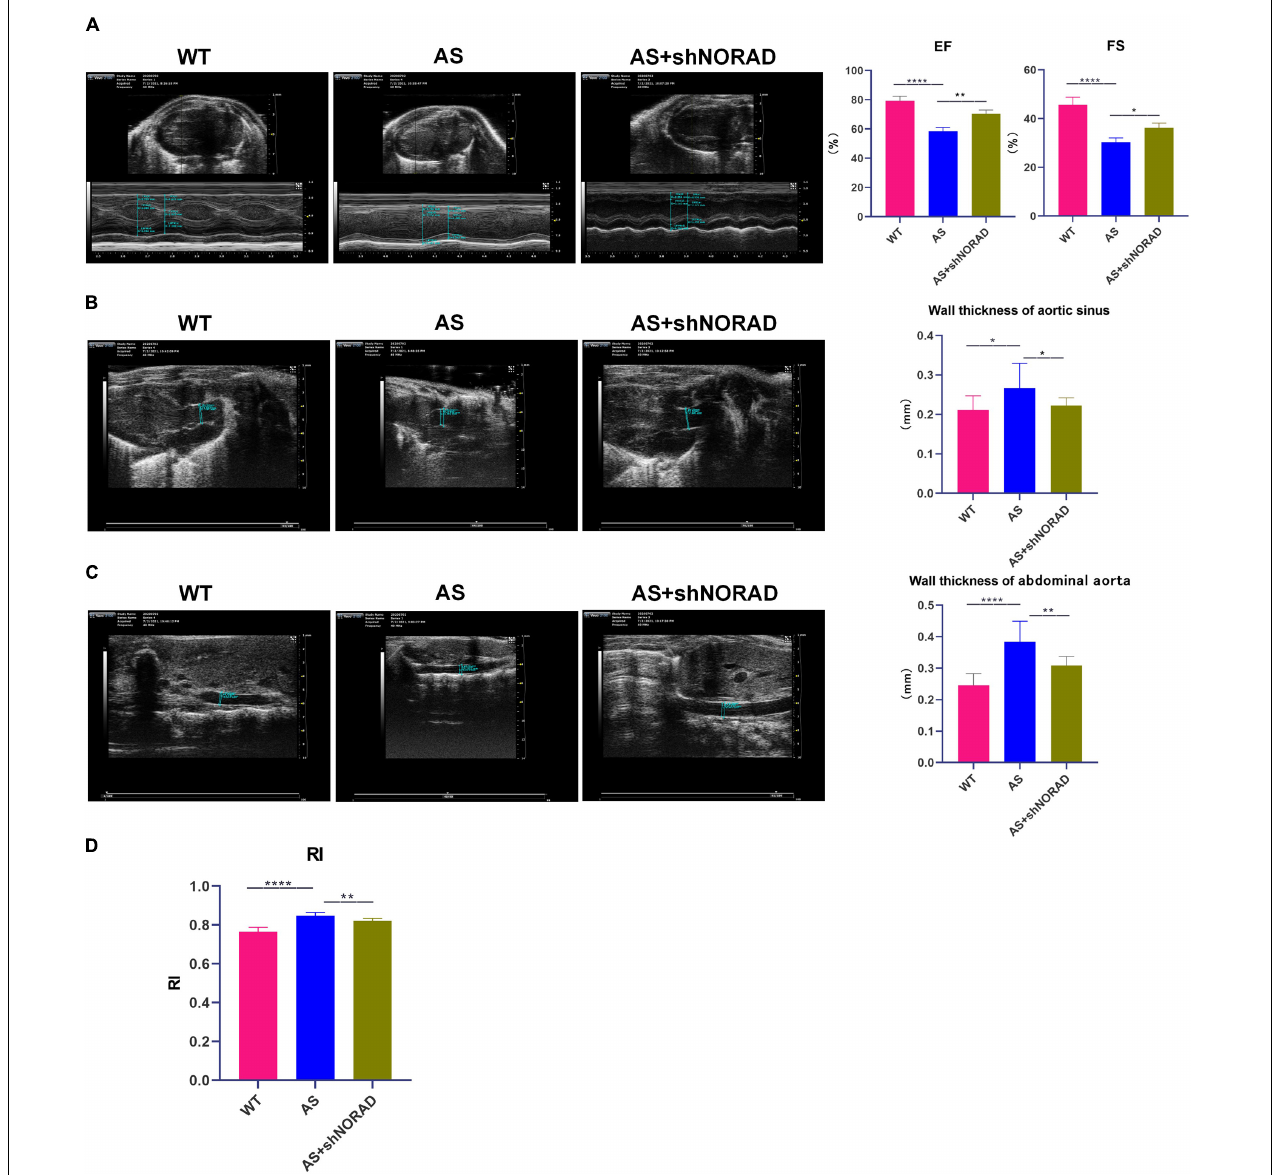
FIGURE 8 | Knockdown of lncRNA NORAD improves heart function and promotes angiogenesis in atherosclerotic mice. (A) Representative ultrasound images of hearts in mice injected with or without shRNA-targeting lncRNA NORAD. The bar graph showed the quantification of ejection fractions (EF) or fractional shortening (FS). (B) Representative ultrasound images of aortic sinus in mice injected with or without shRNA-targeting lncRNA NORAD. The bar graph showed the quantification of wall thickness of aortic sinus. (C) Representative ultrasound images of abdominal aorta in mice injected with or without shRNA-targeting lncRNA NORAD. The bar graph showed the quantification of wall thickness of abdominal aorta. (D) The quantification of resistance index (RI) in mice injected with or without shRNA-targeting lncRNA NORAD. WT, wild type; AS, atherosclerosis; shCtrl, control shRNA; shNORAD, shRNA-targeting lncRNA NORAD. N = 3. * p < 0.05, ** p < 0.01, **** p <